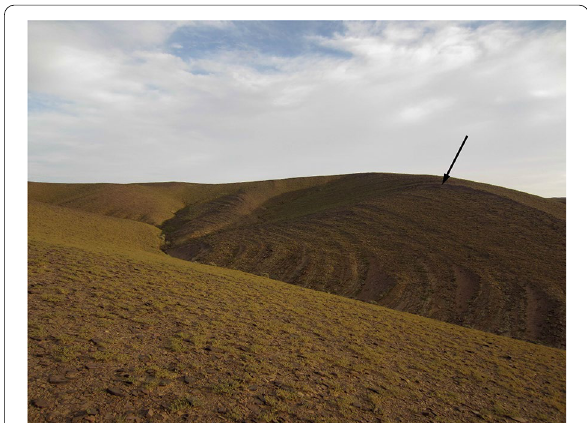
Fig. 3 Photo of the outcrop with some vegetation after a reasonably rainy winter. Note the thin-bedded alternations of siltstone and fine-grained sandstones, which weather differentially relative to one another. Bed-thickness is likely due to variations in clay content, which, in turn, is probably controlled by variations in sea-level and clastic input. The Undichna described here is from the thicker bed marked by the arrow, which runs obliquely down the slopes on both sides of the arrow